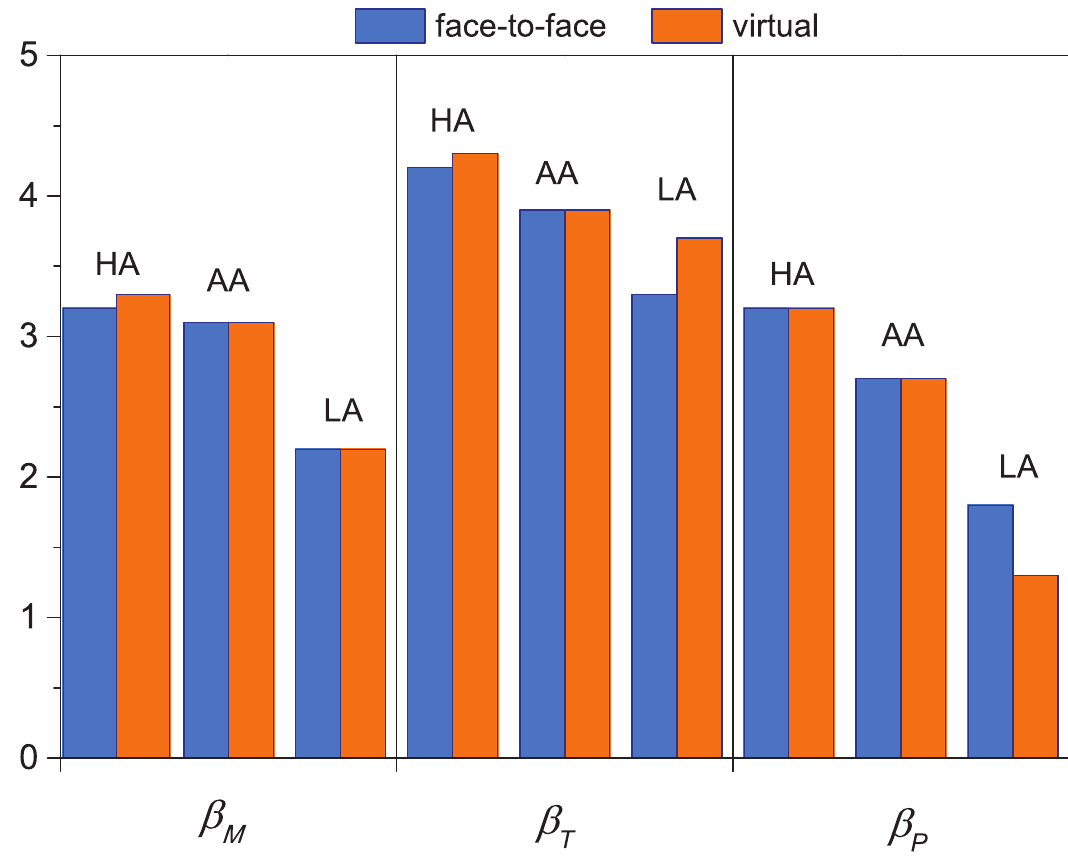
Fig 5. Coefficients b X , b X and b X for each group of students HA, AA and LA obtained with the ANN approach. For each context M T P these coefficients preserve generality with greater importance in the term associated with the interaction with teachers ( b X